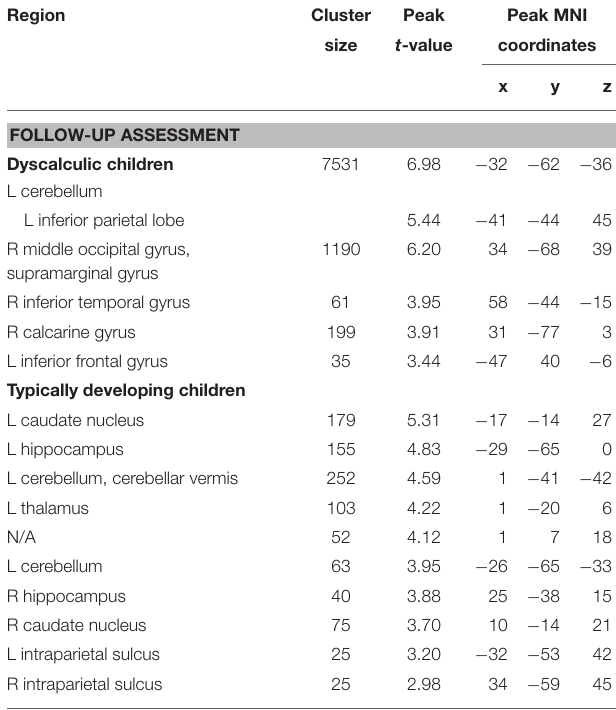
TABLE 3 | Brain areas that showed significant activation for the numerical order vs. control task from dyscalculic and typically developing children at the baseline assessment ( p < 0.01, k ≥ 24, cluster-extend corrected).